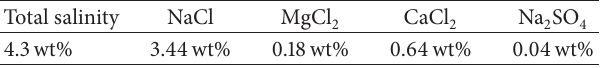
Table 1: Synthetic brine